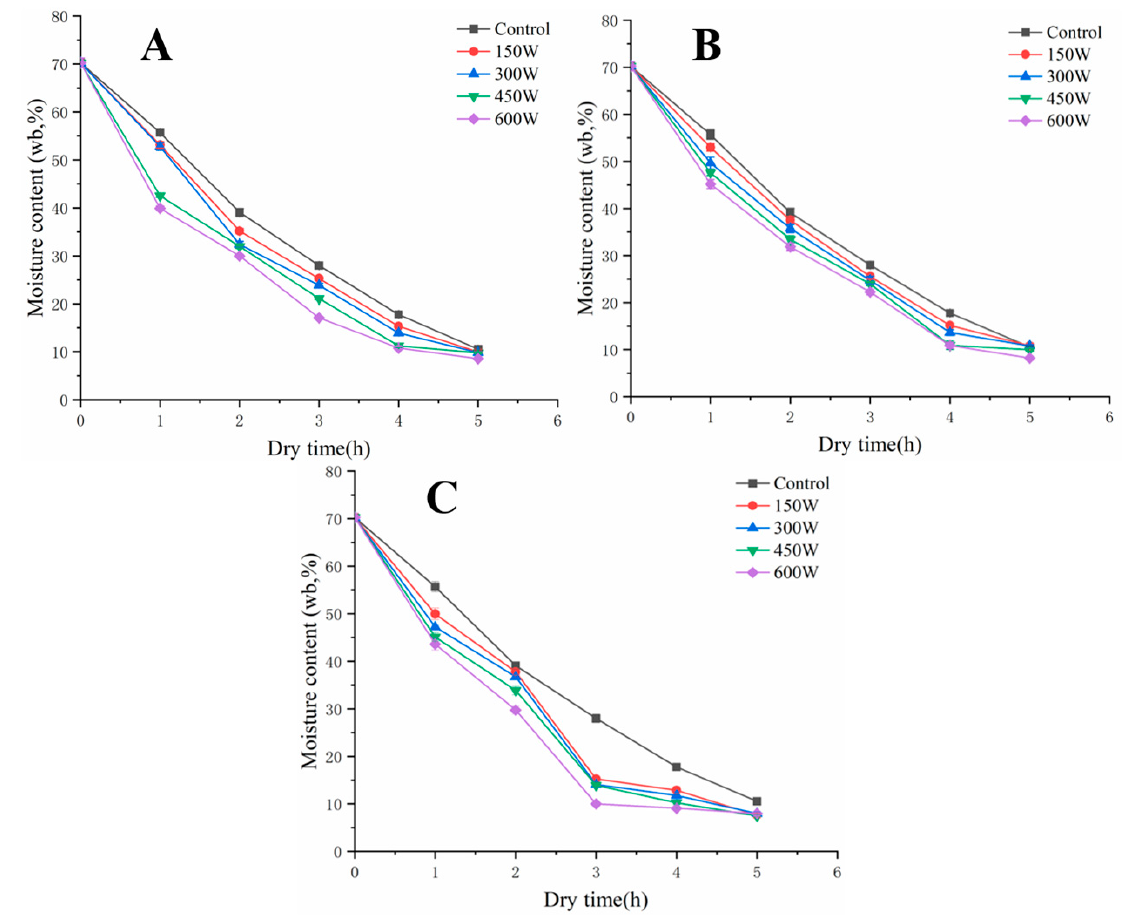
Figure 1. Changes in moisture content of FSI with ultrasonic time and power during VD. Ultrasonic time, 5 min ( A ); ultrasonic time, 10 min ( B ); ultrasonic time, 15 min ( C ). The control was soaked in FSI for the same time for VD. FSI, Flos Sophorae Immaturus . VD, vacuum drying.